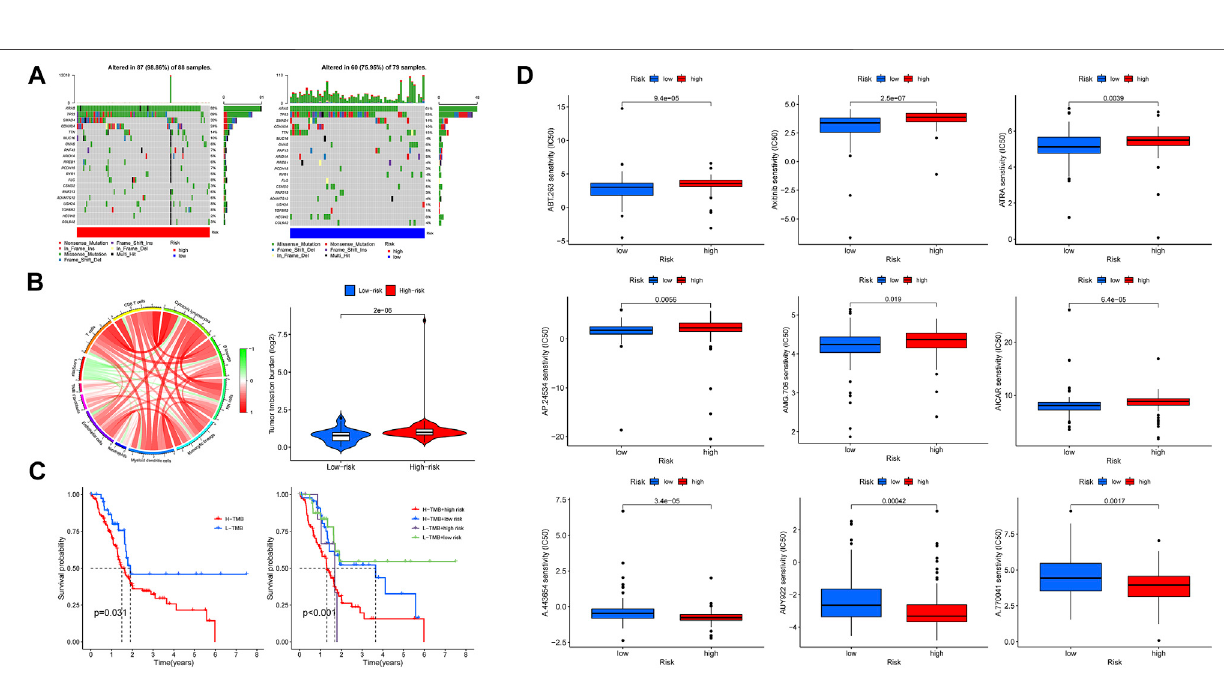
Frontiers in Genetics |